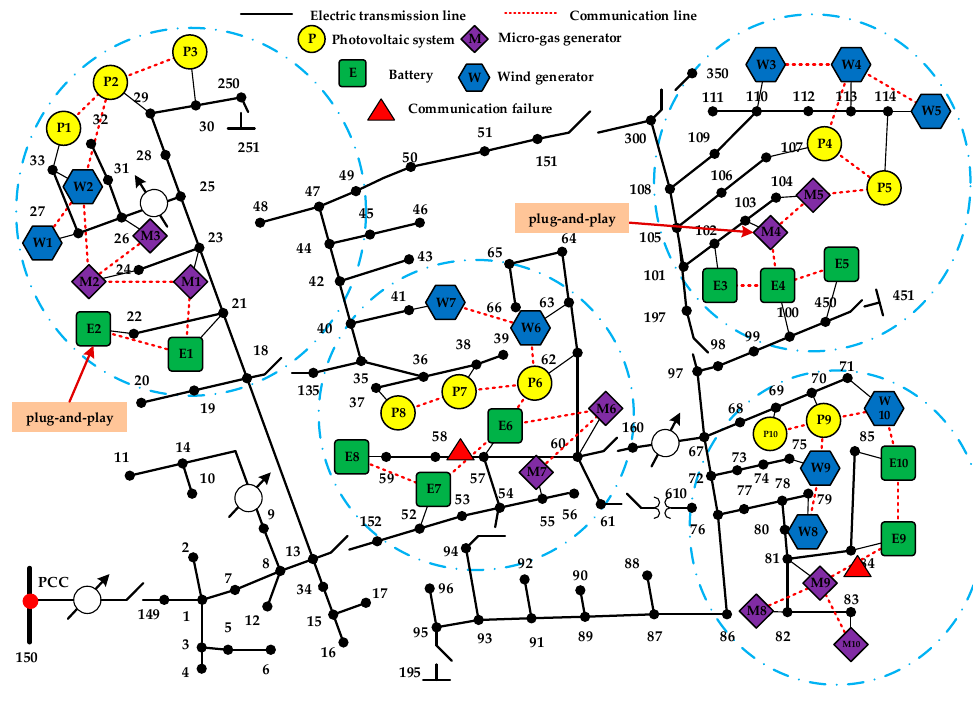
Figure 9. The modified IEEE-123 bus test system in Scenario D.